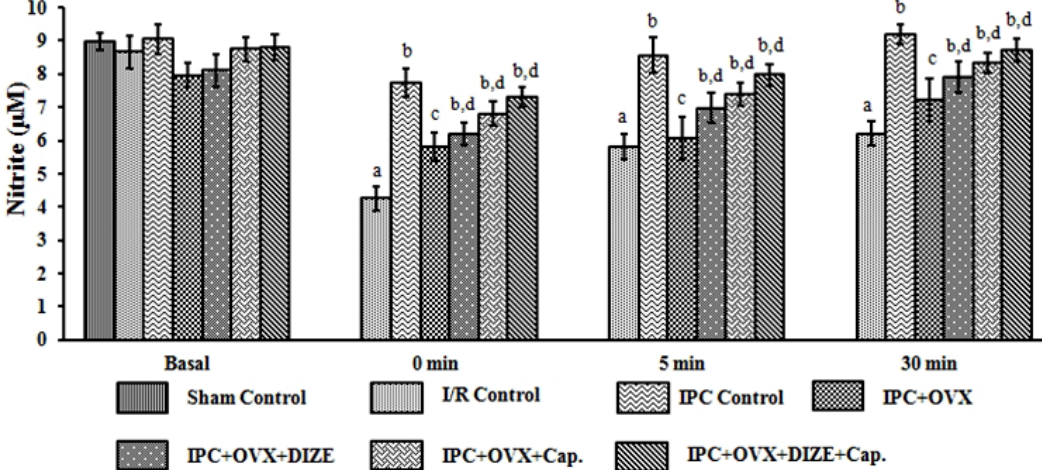
FIGURE 5 - Effect of I/R on the release of nitrite, effect of ischemic preconditioning (IPC) on the release of nitrite in normal and OVX rat heart, effect of DIZE perfusion on the release of nitrite in ovariectomized rat heart and effect of Cap. alone or in combination with DIZE on the release of nitrite in OVX rat heart. I/R denotes ischemia reperfusion; IPC denotes ischemic preconditioning; OVX denotes ovariectomy; DIZE denotes diminazene aceturate; Cap. denotes captopril. Values are expressed as mean ± S.D, a = p< 0.05 vs. Sham control; b = p< 0.05 vs. I/R control; c = P< 0.05 vs. IPC in normal rat heart; d = p< 0.05 vs. IPC in OVX rat